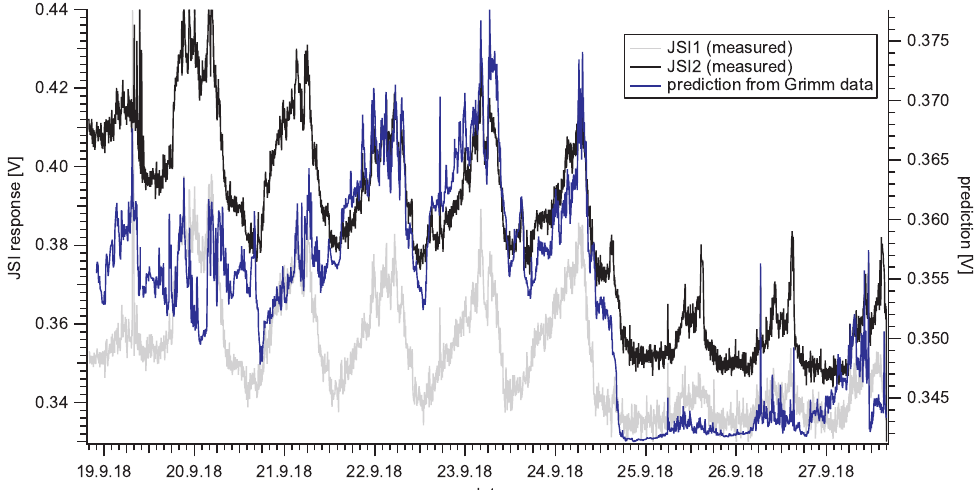
Figure 11. Sensor output in an environmental measurement and comparison with predicted output calculated from particle distribution measurement with OPC Grimm device (JSI1 R 2 = 0.47, JSI2 R 2 = 0.58). The data time resolution is five minutes. The JSI1 signal is shown just for information, since it was not